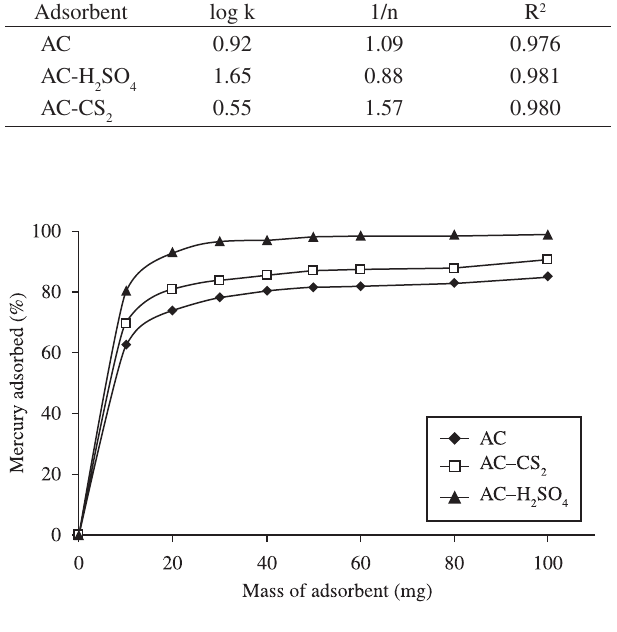
Table 4. Parameters of the Freundlich equation.